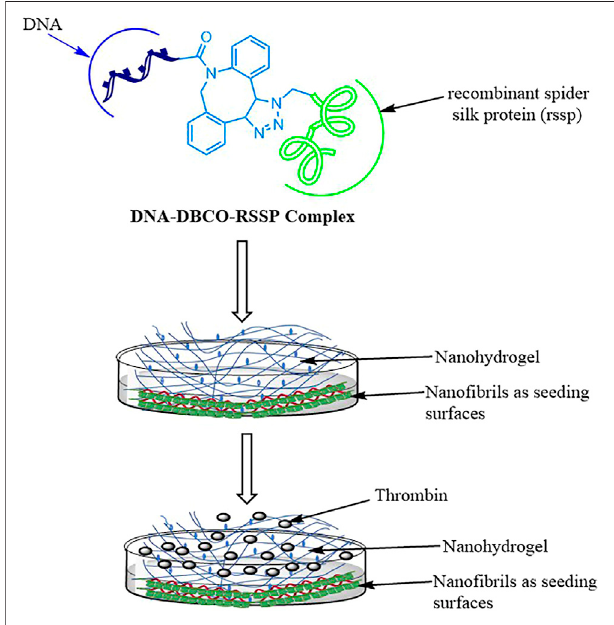
FIGURE 4 | Preparation of DNA-spider silk protein-based nanohydrogels for delivery of thrombin ( fi gure is modi fi ed and redrawn from the original work of Humenik et al.,